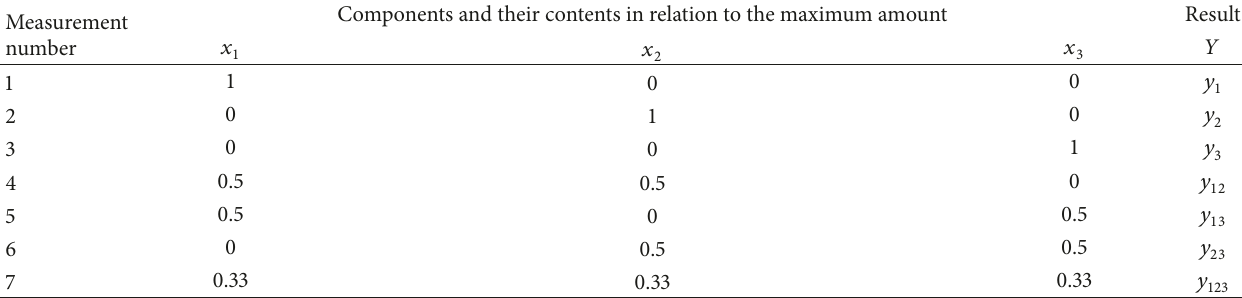
Table 1: Design matrix for the third-degree polynomial for the three-component system. Measurement